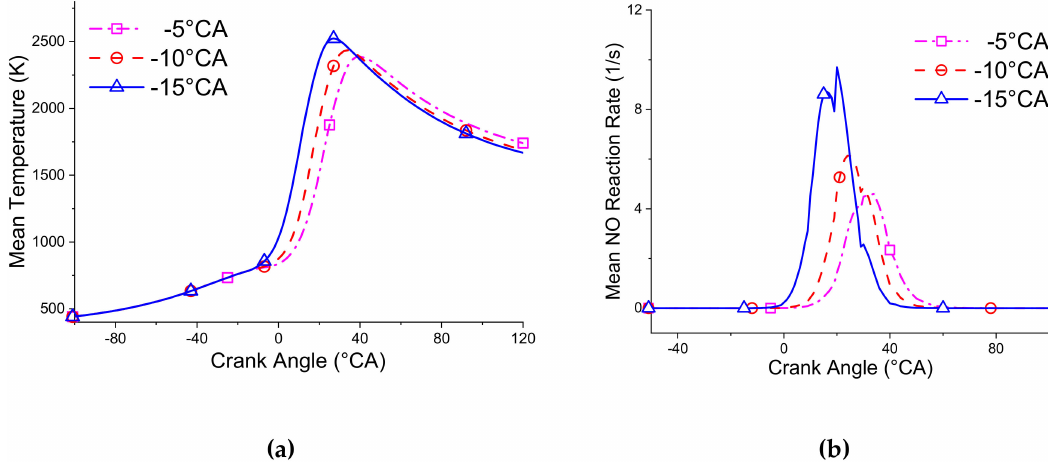
Figure 4. Average temperature and NO production rate at di ff erent spark timings: ( a ) average temperature; ( b ) NO generation